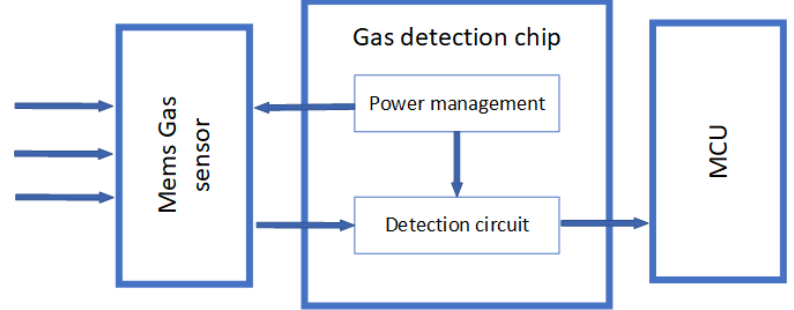
Figure 8. Structure of Gas Detection Systems